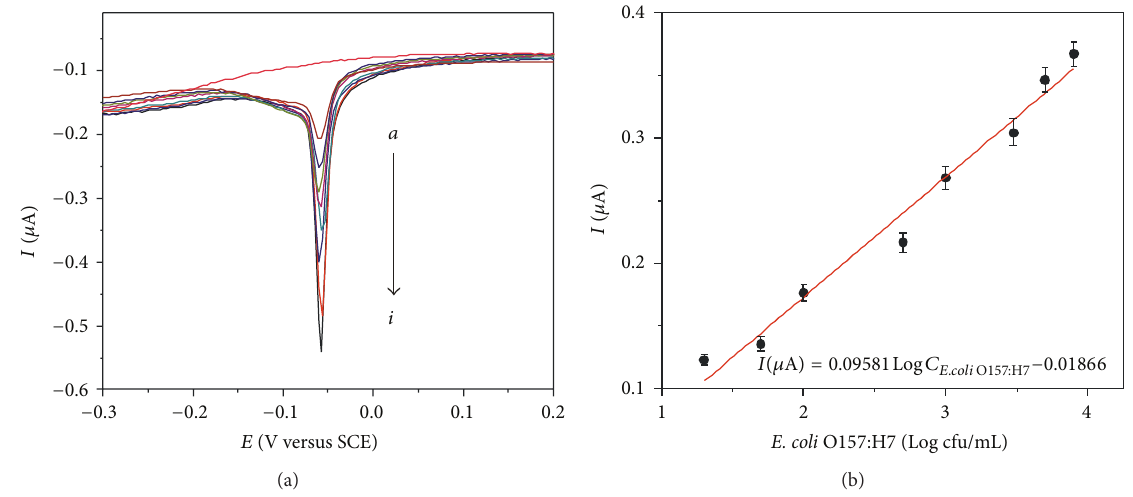
Figure 4: (a) Typical electrochemical DPV curves corresponding to released Ag + from Ag@SiO 2 labels with increasing concentration of E. coli O157:H7 (from 𝑎 to 𝑖 : 0, 20, 50, 100, 500, 1000, 3000, 5000, and 8000 cfu/mL, resp.). (b) Calibration curves of the immunosensor for E. coli O157:H7